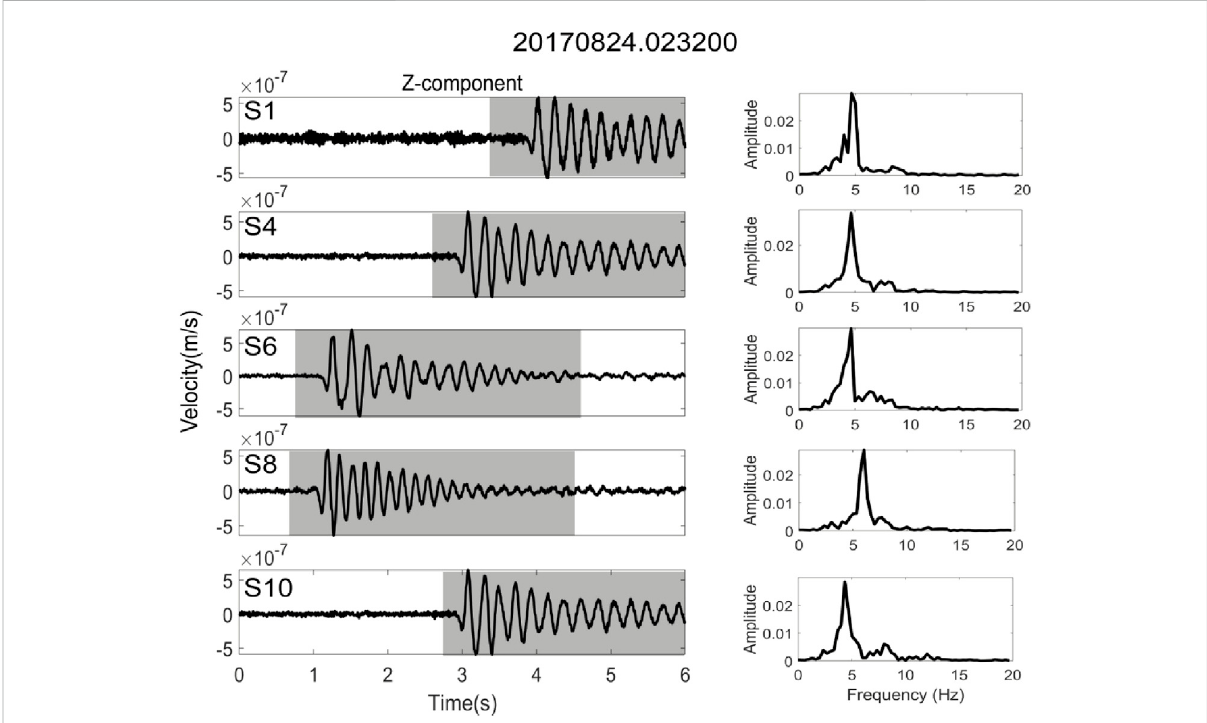
FIGURE 6 Zoom-in waveforms ofthesecond event (left)and thecorresponding frequency spectra (right) at fi vestationsfor the pairedsignal observed on 24 August 2017, 02:32:00 UTC. The frequency spectra are computed using the waveforms in the time windows marked by the grey